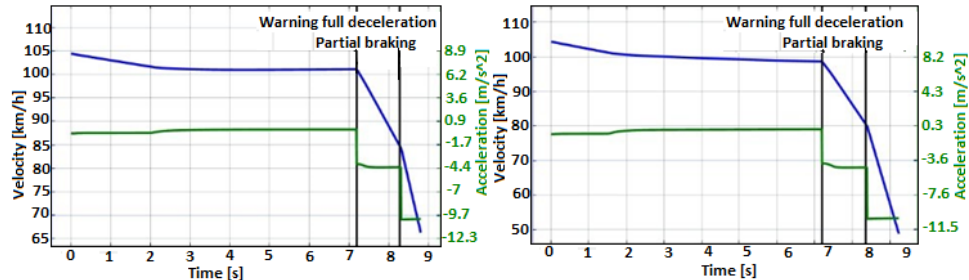
Figure 8. Speed profiles of ego-vehicle. Coefficient of rolling friction 0.02 and 0.04.